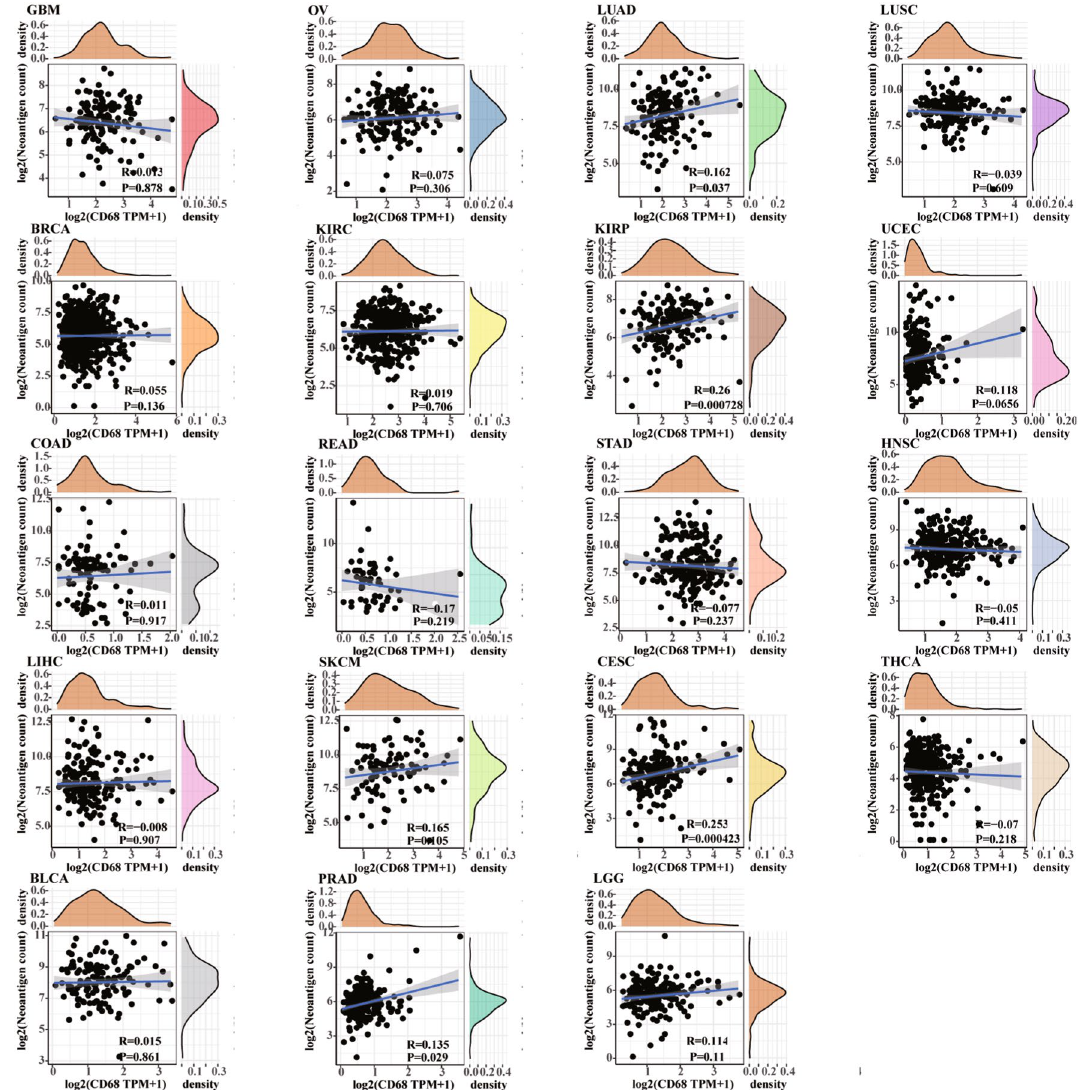
Figure 6. Relationship between neoantigen counts and CD68 expression in